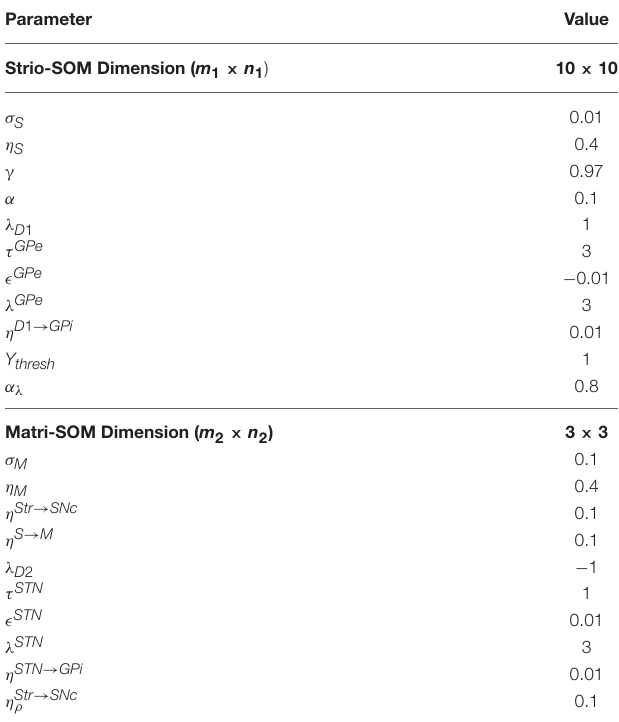
TABLE 1 | Parameter values for single context and multi context tasks.